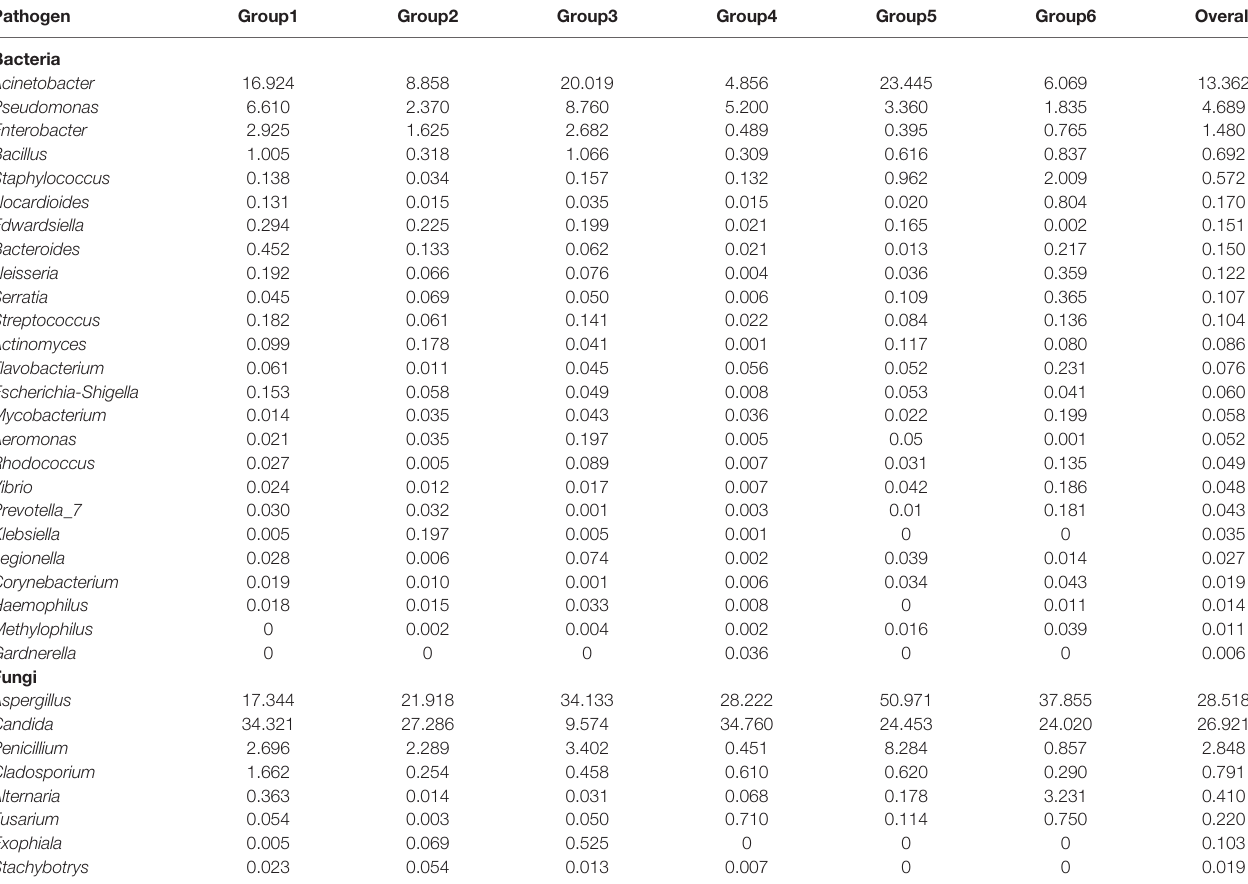
TABLE 3 | The overall relative abundance (%) of potential pathogenic microorganism at genus level and that among six groups of DUWL bio fi lm samples. Group1